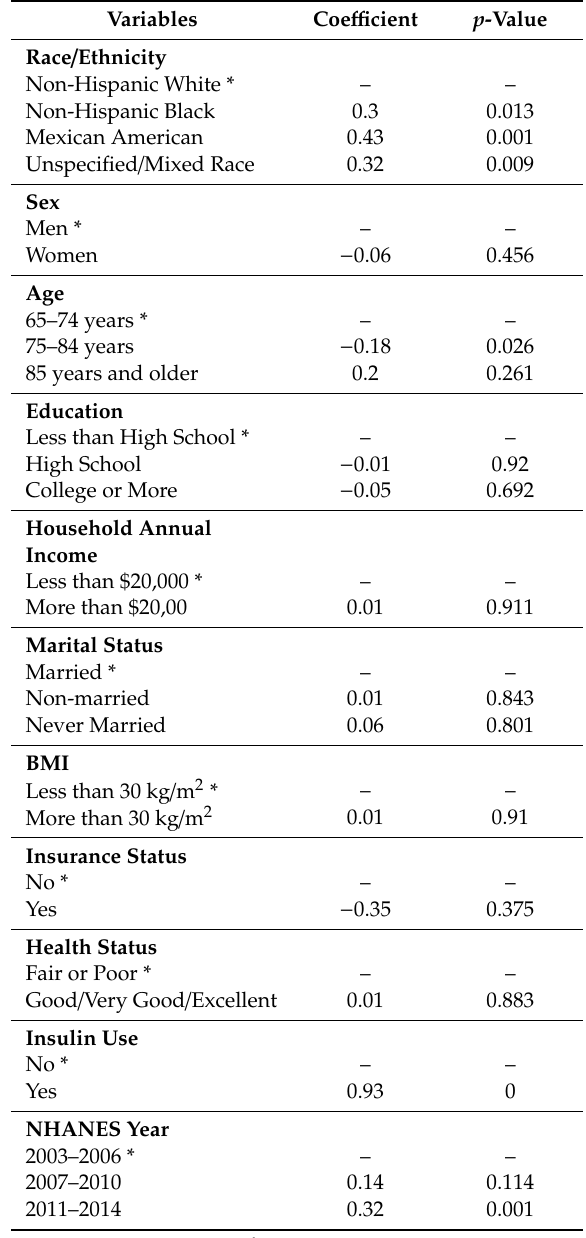
Table 3. Adjusted linear regression of hemoglobin A1c by race /